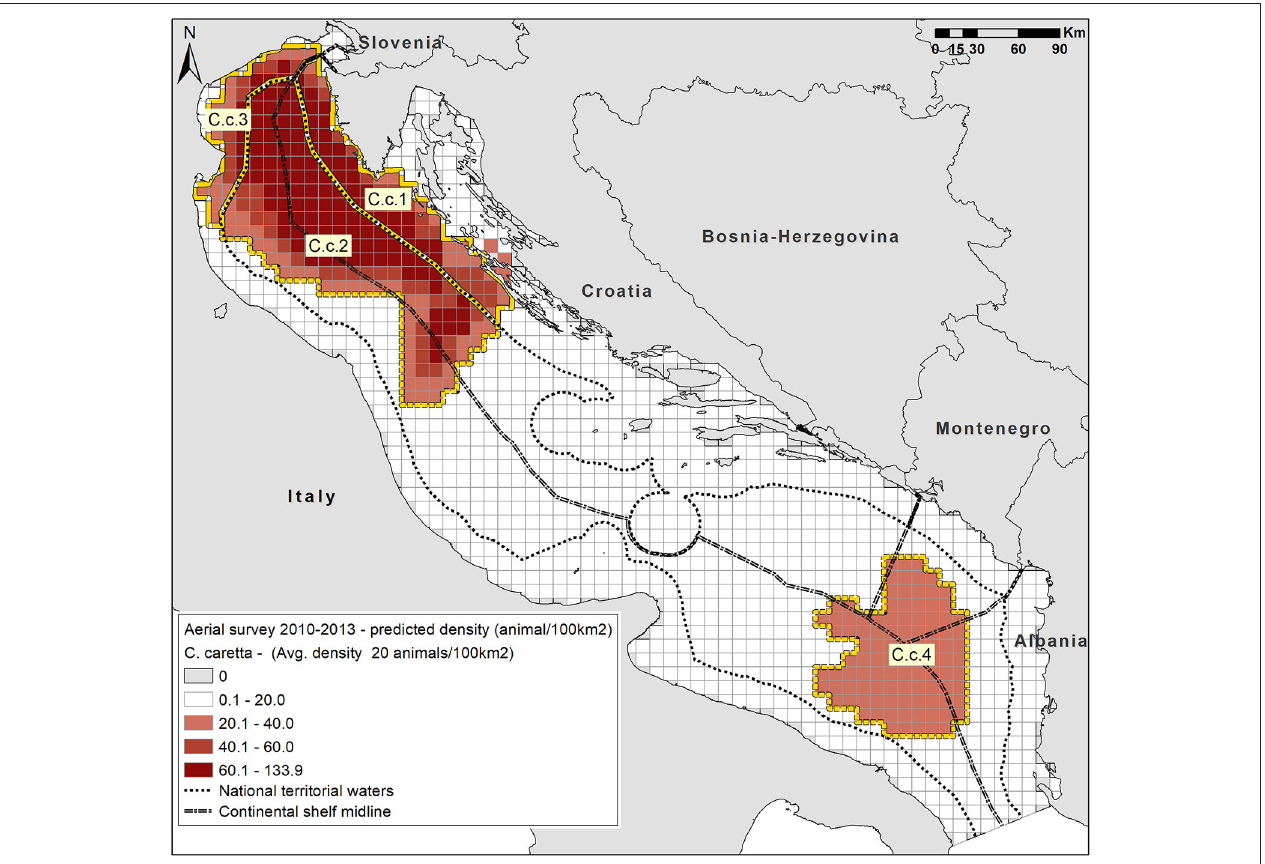
FIGURE 2 | Density Surface predicted distribution of sea turtles (mostly loggerhead turtles) in the Adriatic Sea based on 2010 and 2013 aerial surveys data (darker red scale indicates higher relative density). The scales represent below average (white; L), and then up to twice (L-MD), up to three times (M-HD), up to four times (H-HHD) and greater than four times (MAXD), in shades of dark red. The proposed key areas ( Table 3 ) are identified by yellow dotted (within 12nm), dashed (over 12nm) and dot-dashed shapes (areas within and over 12nm).